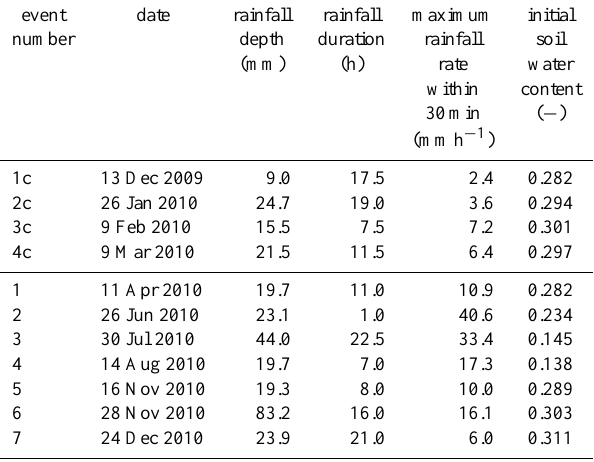
Fig. 3. Water content profiles simulated by the adopted model for homogeneous soil and specific values observed at different depths during (a) the infiltration stage, (b) the redistribution stage. Event 1 of Fig. 2 (see also Table 2). Saturated hydraulic conductivity 2mmh − 1 . Table 2. Main characteristics of a few simulated events using for calibrating the saturated hydraulic conductivity of the parent soil (events 1c–4c) and for the successive representative applications of the study models (events 1–7).